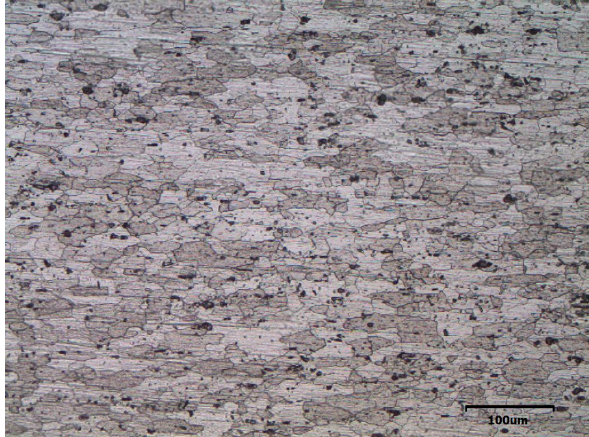
Figure 2: Schematic diagram of butt